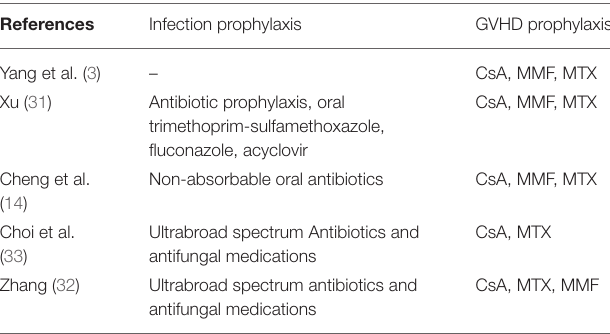
TABLE 4 | Summary the data on infection prophylaxis and GVHD prophylaxis